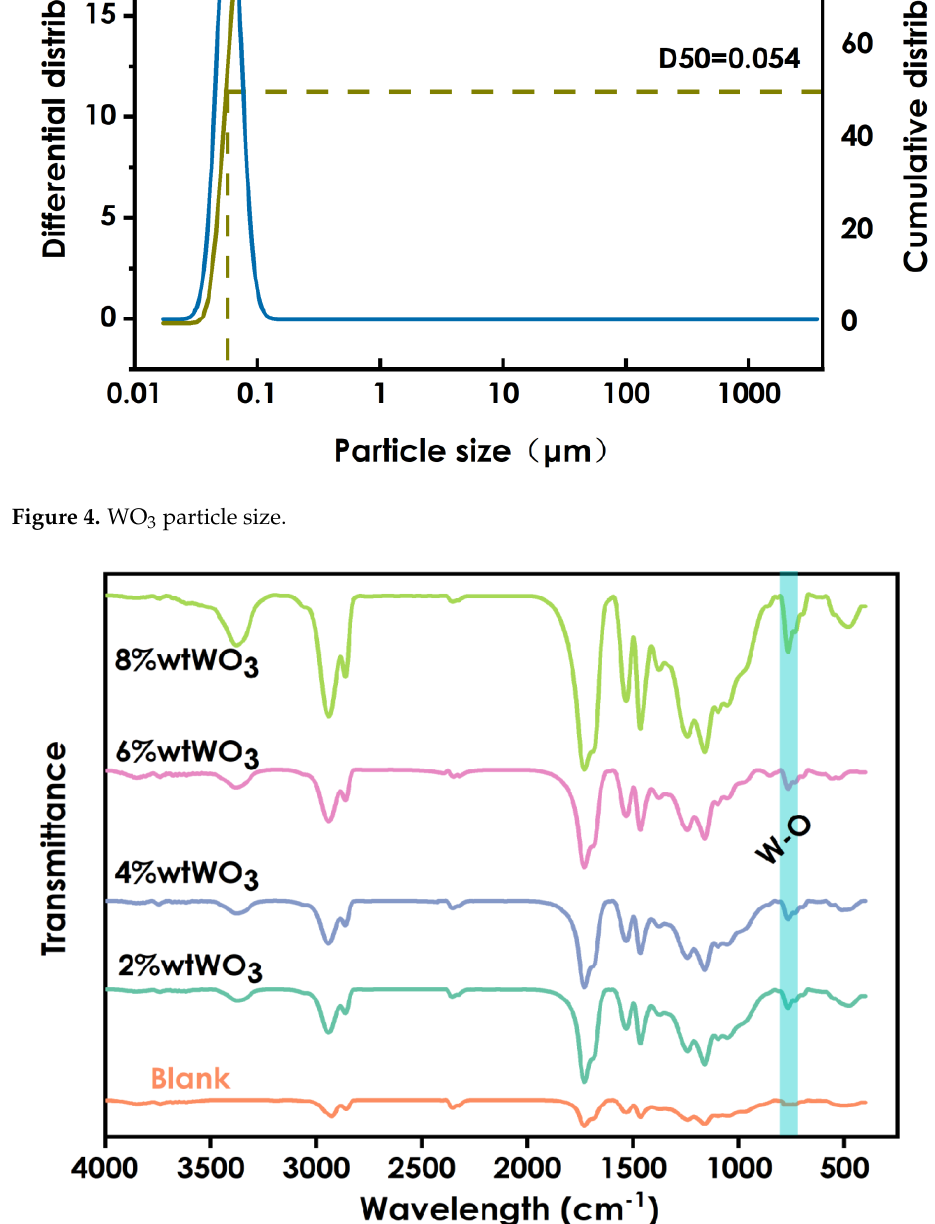
Figure 5. Infrared spectra of coatings prepared using different amounts WO 3 (0%,2%,4%,6%,8%) .